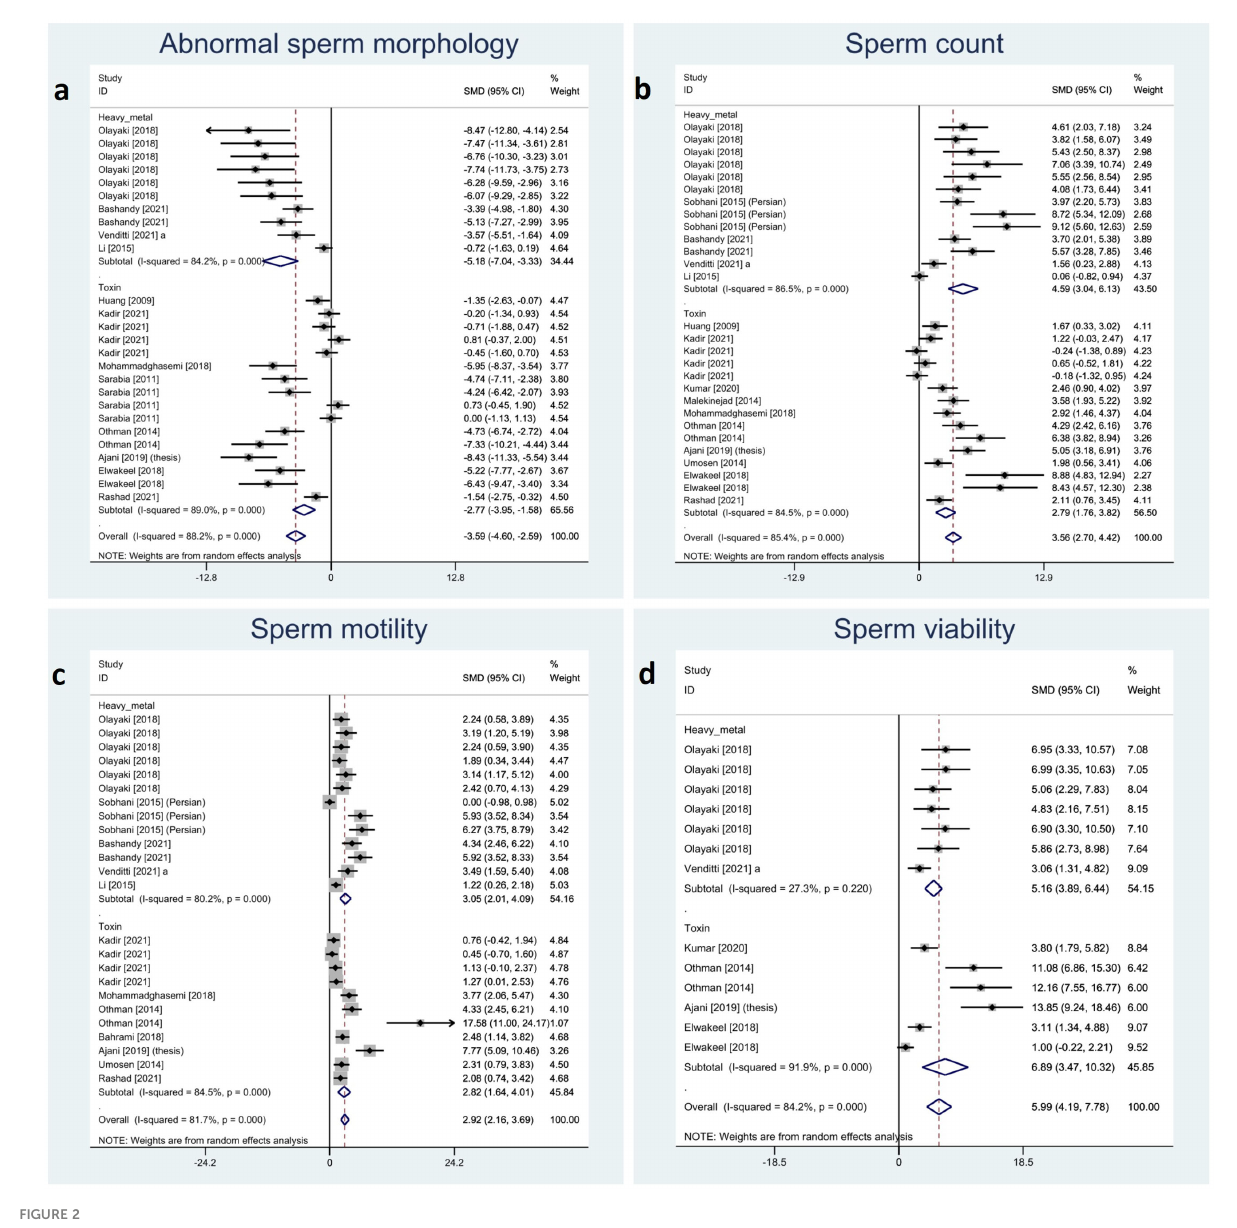
FIGURE 2 Forest plots for overall and subgroup effect measures on the impact of melatonin therapy on sperm characteristics including (A) abnormal sperm morphology, (B) count, (C) motility, and (D)